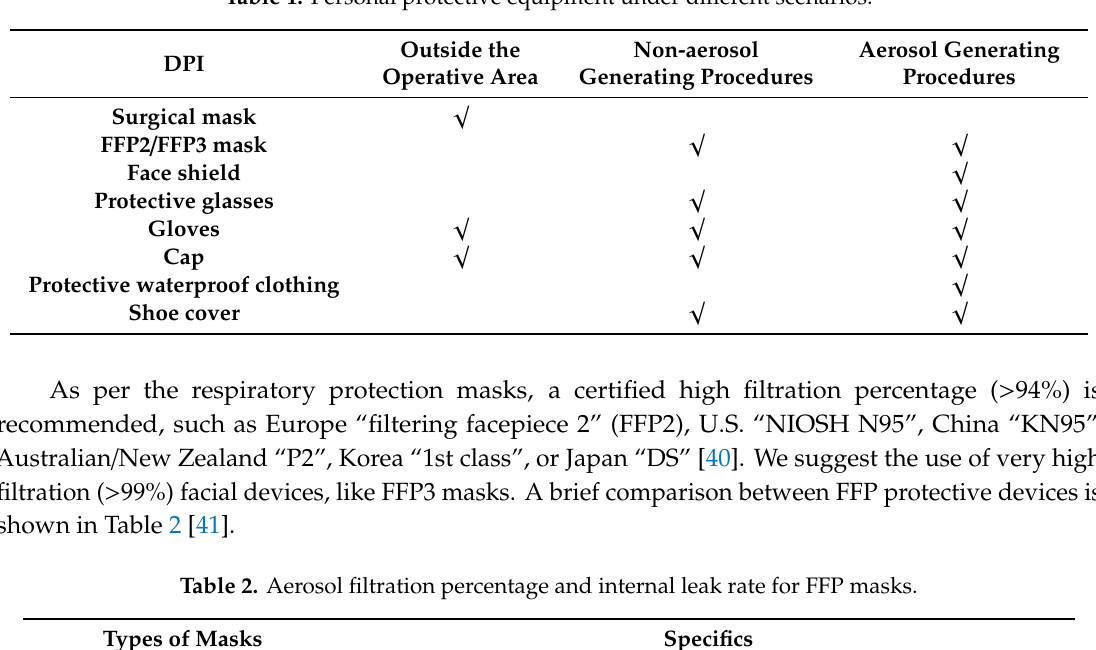
Table 1. Personal protective equipment under di ff erent scenarios.